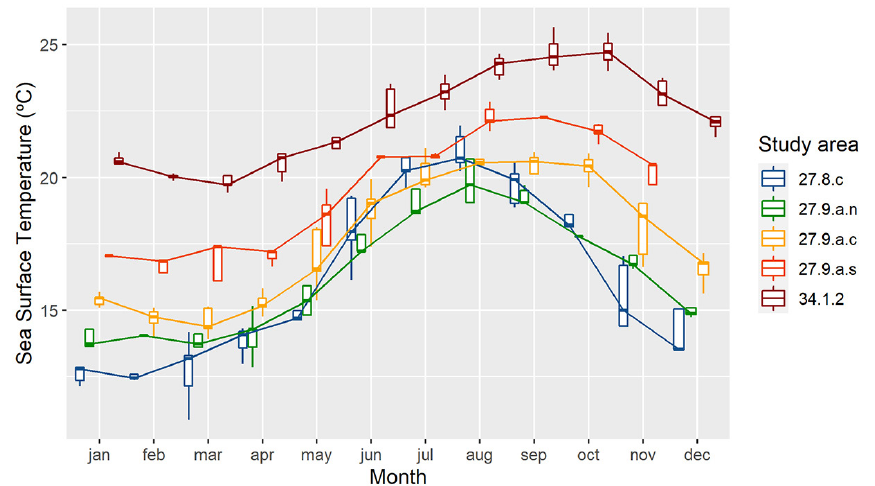
Fig. S5. – Monthly variability of sea surface temperature (SST) in each study area. Geographical study areas from south to north are 34.1.2, Canary Islands; 27.9.a.s, Gulf of Cadiz; 27.9.a.c, W Portuguese coast; 27.9.a.n, NW Spanish coast; 27.8.c., Cantabrian Sea. Horizontal line within the boxes represents the median, boxes represent the inter-quartile range (IQR) or distance between the first (25%) and third (75%) quartiles, whiskers represent ±1.5 * IQR and solid line connect the medians.